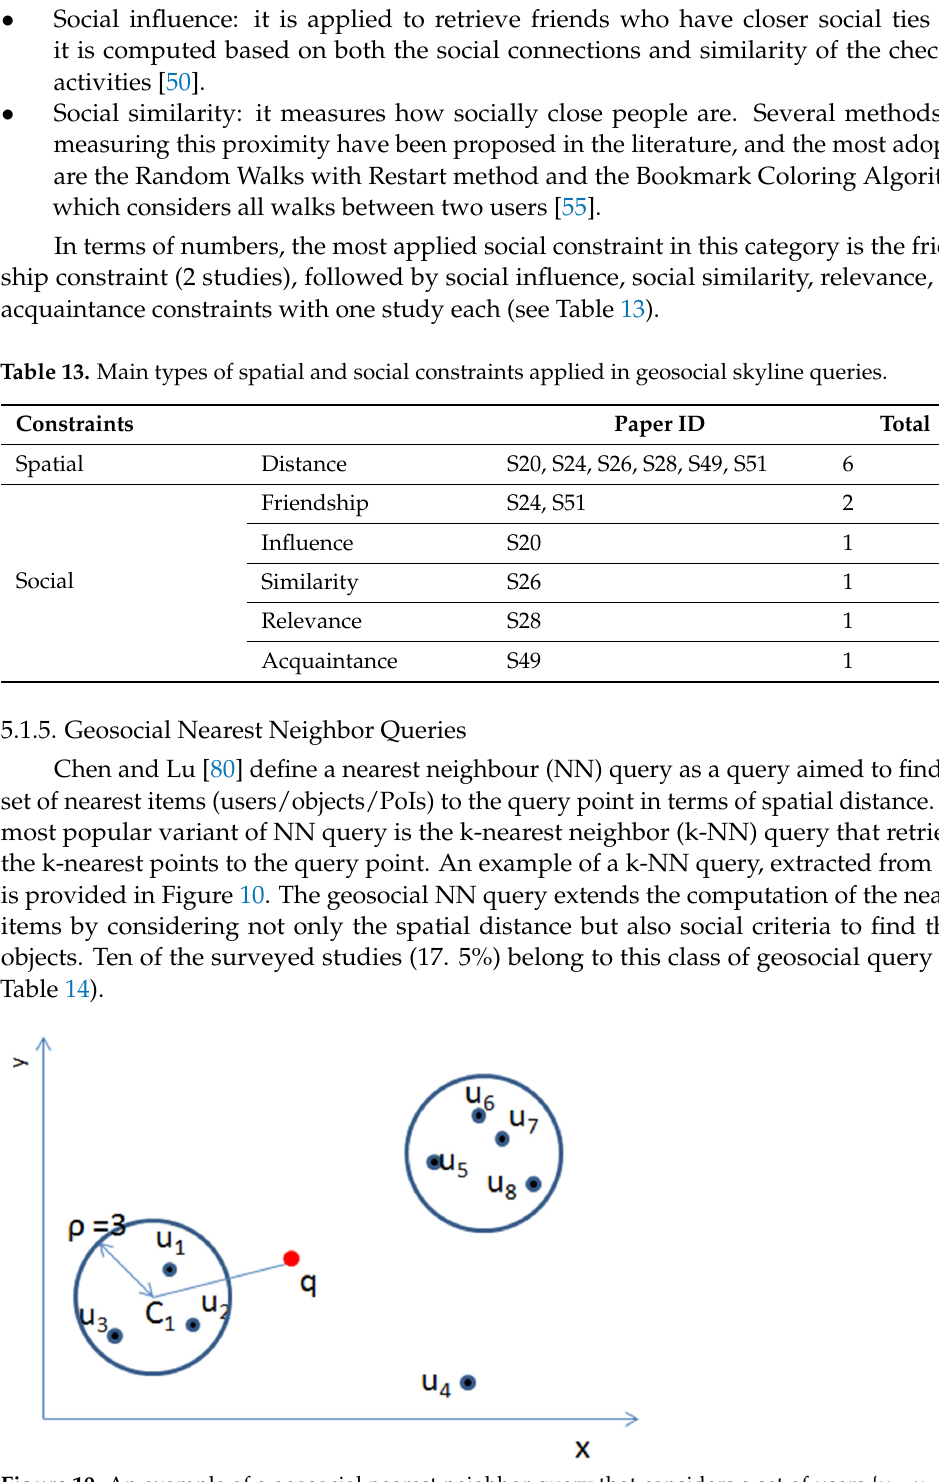
Figure 10. An example of a geosocial nearest neighbor query that considers a set of users {u 1 , u 2 , . . . , u 8 } and the query location q. The query returns C 1 with radius constraint ρ = 3, which is the nearest neighborhood to q.